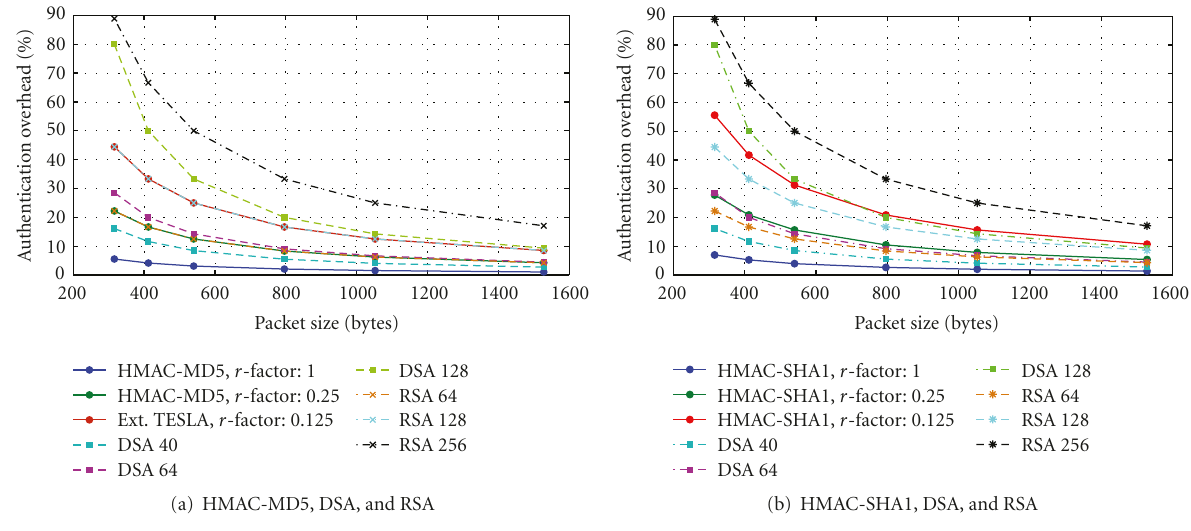
Figure 8: Comparison of percentage byte overhead due to authentication for 500MB data.